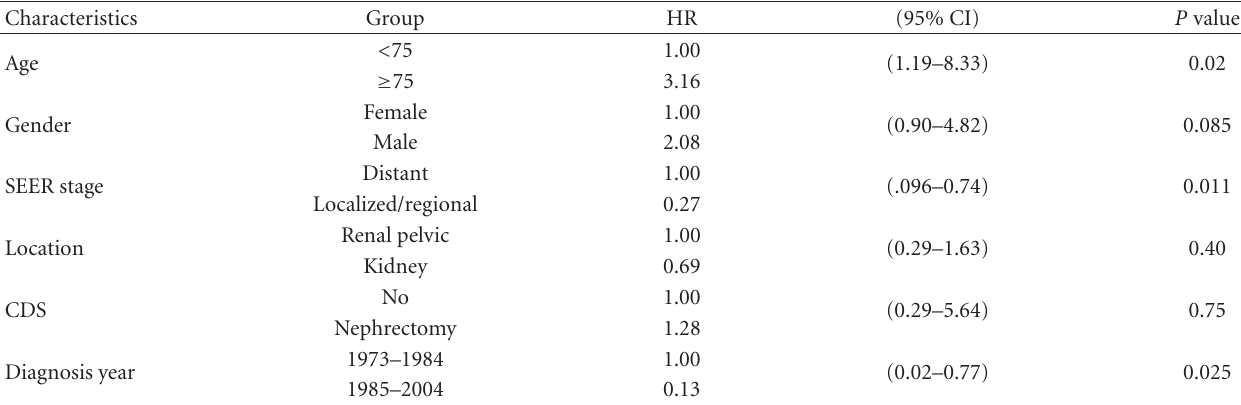
Table 3: Multivariate analyses of factors associated with mortality in patients with carcinosarcoma of kidney and renal pelvis (CSKP).